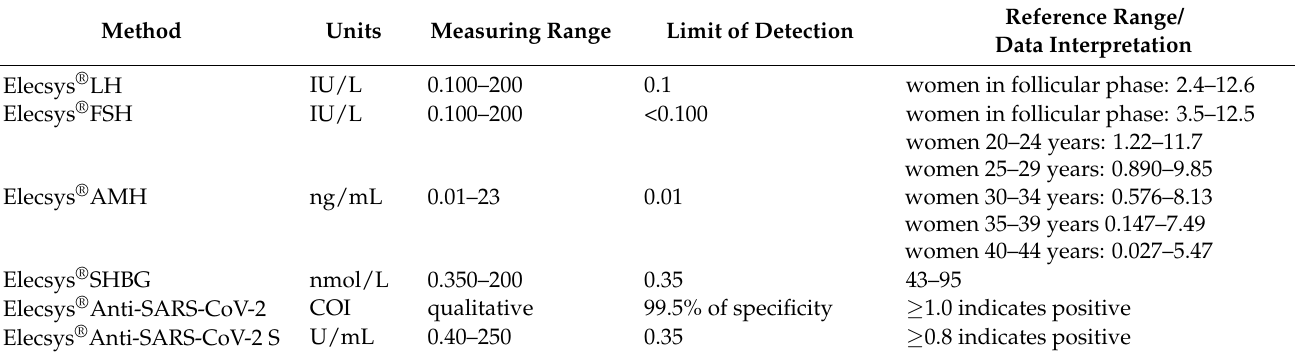
Table 4. Immunoassay method performance